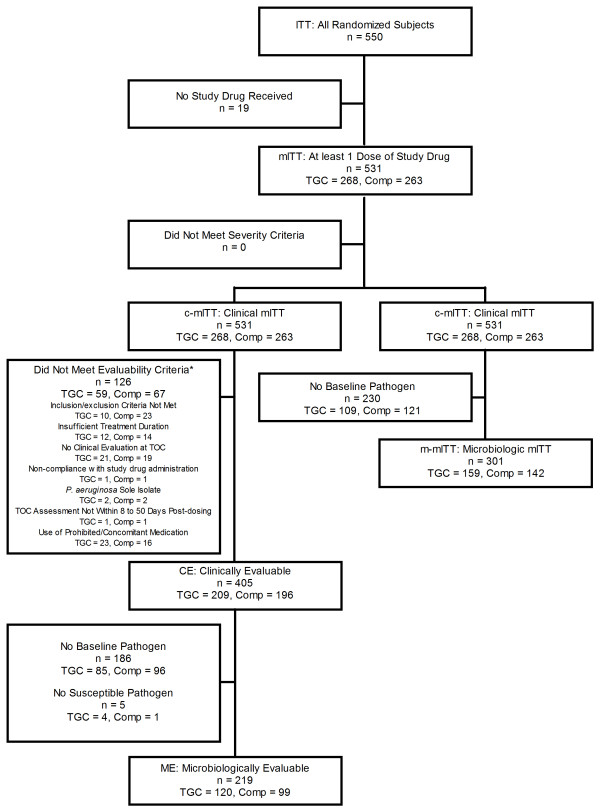
Analysis population. Footnote: *Subjects could be excluded for more than 1 reason. ITT, intent-to-treat; mITT, modified intent-to-treat; TGC, tigecycline; Comp, comparator. c-mITT, clinical modified intent-to-treat; TOC, test-of-cure; m-mITT, microbiologic-modified intent-to-treat; CE, clinically evaluable; ME, microbiologically evaluable.